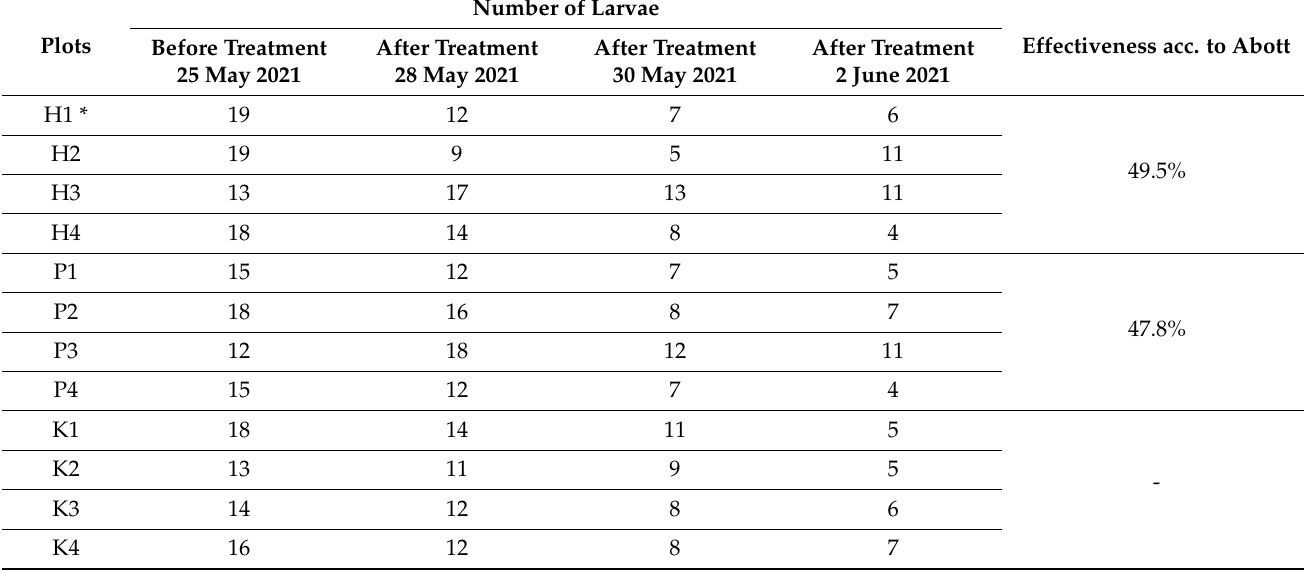
Table 1. The effectiveness of performed treatment based on the number of O. melanopus larvae.